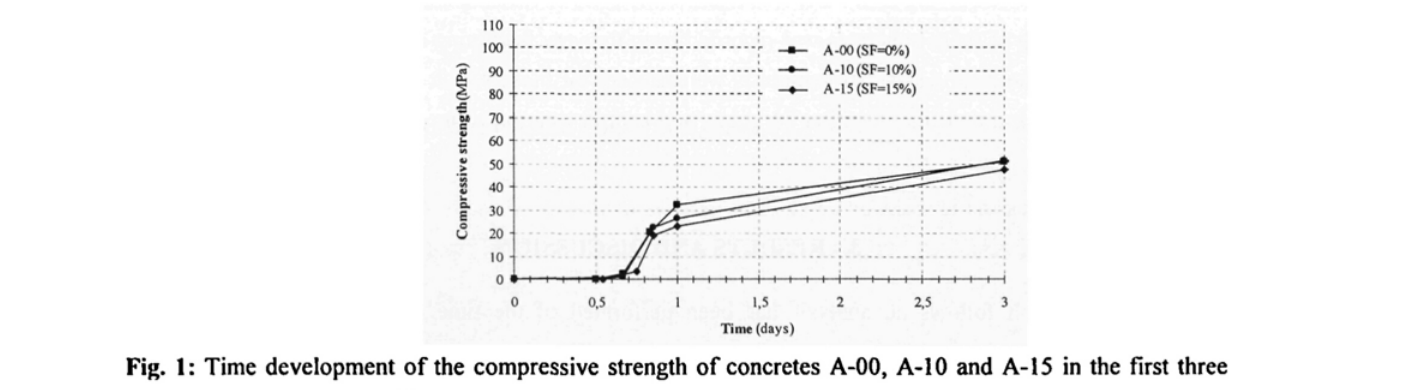
Fig. 1: Time development of the compressive strength of concretes A-00, A-10 and A-15 in the first three days.